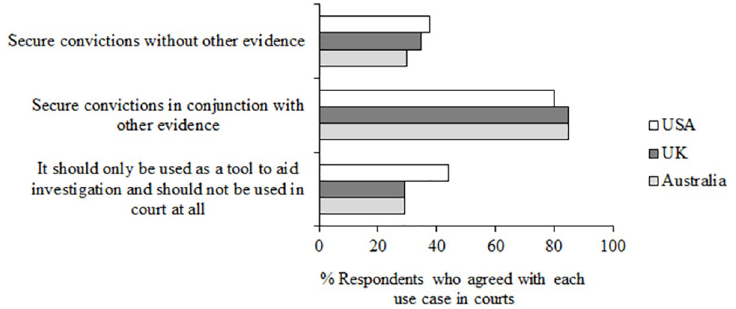
Fig 9. Questions 13–15 data. Percent of participants who agree (responding 4, 5 or 6 on the scale of agreement) with each use case in court (questions 13–15). Section 5: Accuracy. The final section of the questionnaire asked about public perceptions